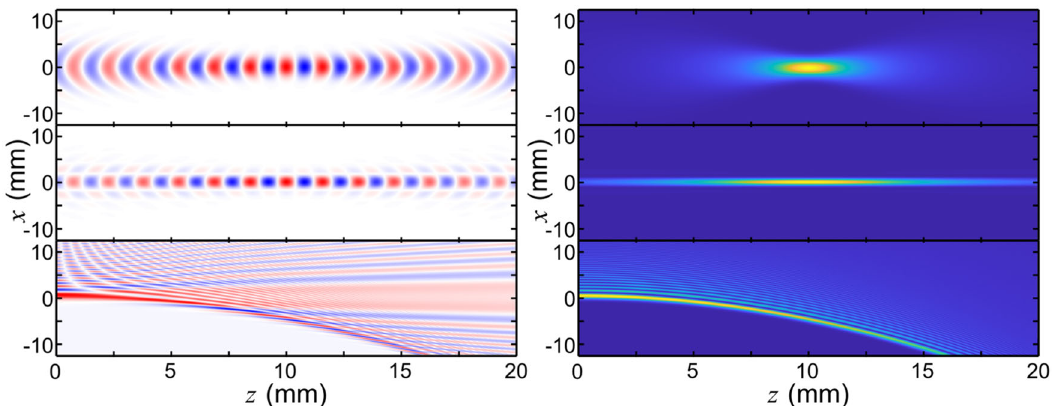
Fig.3|Engineerednear- fi eldradiationpatterns. Calculatedelectric fi eld(left)andintensity(right)patternsforthreeengineerednear- fi eldradiationpatterns:afocused Gaussian beam (top), a Bessel beam (middle), and an accelerating Airy beam